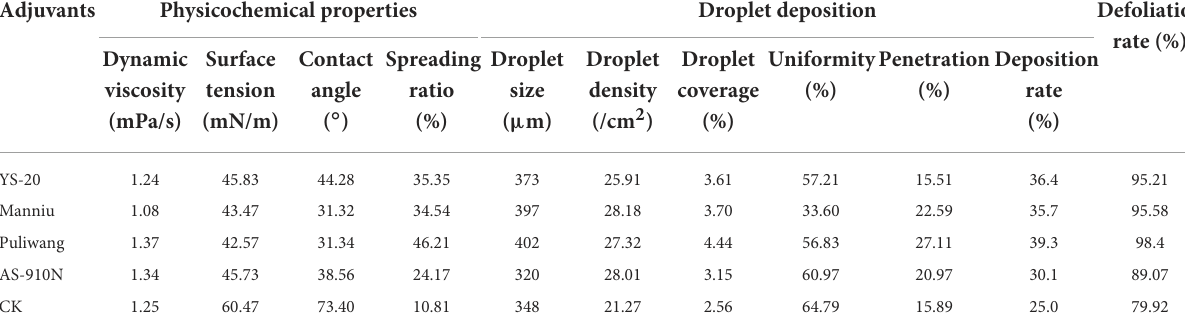
TABLE 7 The effects of aerial application of adjuvant-enhanced defoliants on physicochemical properties, droplets deposition, and defoliation rate.